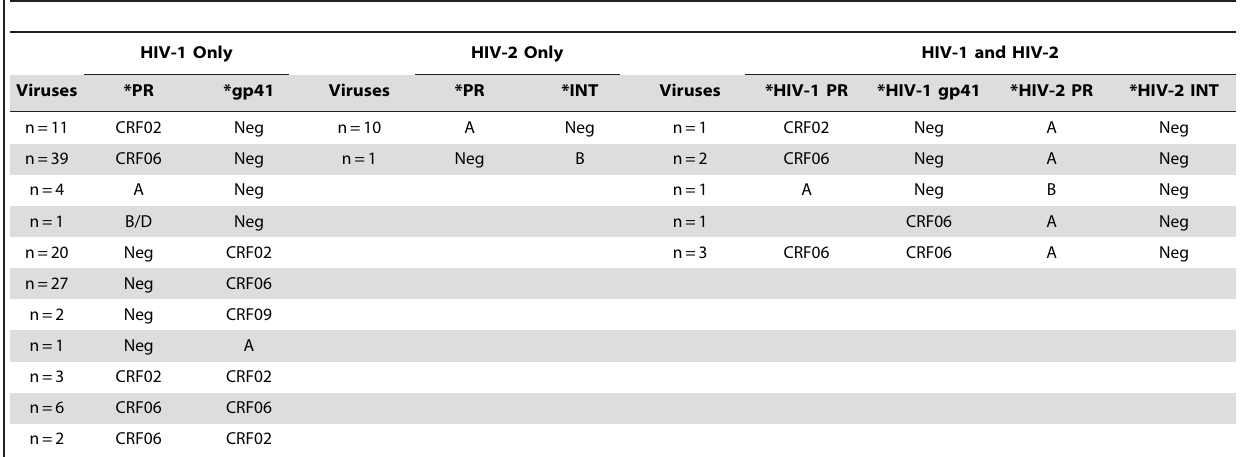
Table 1. Summary of distribution of HIV-1 (env gp41, PR) and HIV-2 (PR and INT) gene sequences.